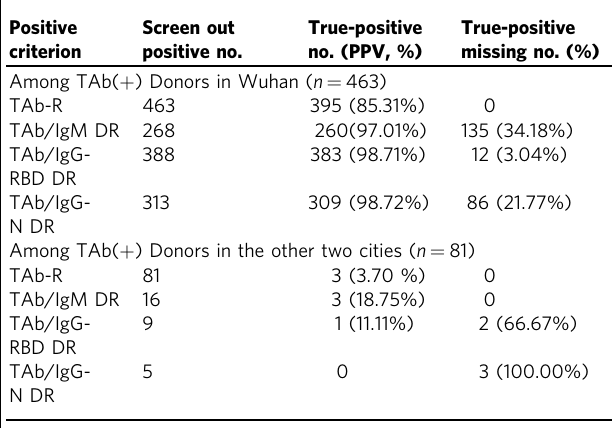
Table 2 Comparison of performance of the combined markers in the detection of con fi rmatory SARS-CoV-2 antibody among blood donors in Wuhan and other